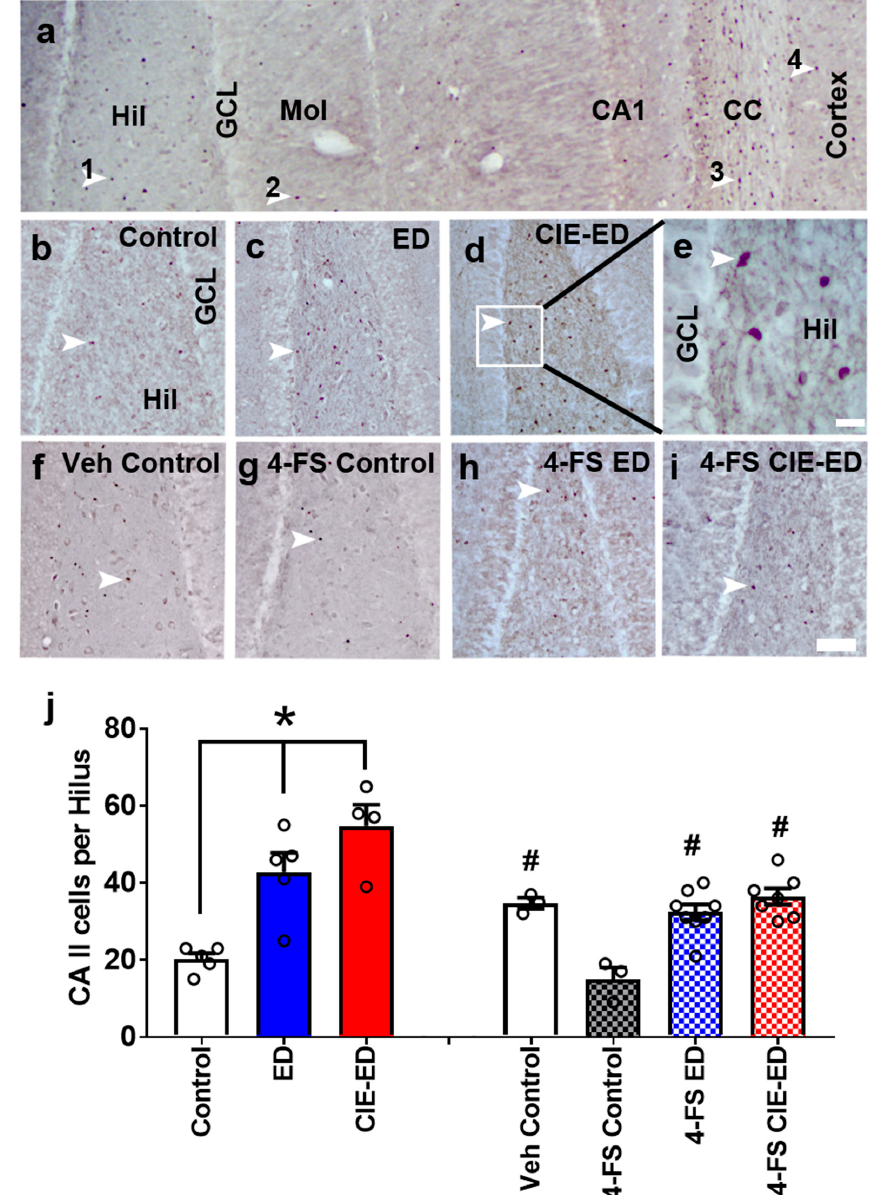
Figure 3. Carbonic anhydrase type II (CA II) expression in the adult rat hippocampus. ( a ) Photomicrograph of CA II immunohistochemistry in the hippocampus and cortex from one control rat. CA II+ cells appeared as single cells; each immunoreactive cell is pointed with an arrowhead. 1 ‐ CA II+ cell in the hilus (Hil); 2 ‐ CA II+ cell in the molecular layer (Mol); 3 ‐ CA II+ cell in the corpus callosum (cc); 4 ‐ CA II+ cell in the cortex. ( b – i ) 100× images of the hilus used for quantitative analyses of CA II cells. ( e ) Zoomed in image shown in ( d ) to indicate the morphology of CA II+ cells in the hilus. Scale bar in ( e ) is 20 μ m; scale bar in ( i ) is 50 μ m (applies b – d and f – i ). ( j ) Number of CA II+ cells in the hilus. n = 5 controls, n = 5 ED, n = 4 CIE-ED, n = 3 vehicle controls, n = 3 4-FS controls, n = 8 4-FS ED rats, n = 7 4-FS CIE-ED rats. * p < 0.05, compared to controls; # p < 0.05 compared to 4-FS control. Data are expressed as mean ±